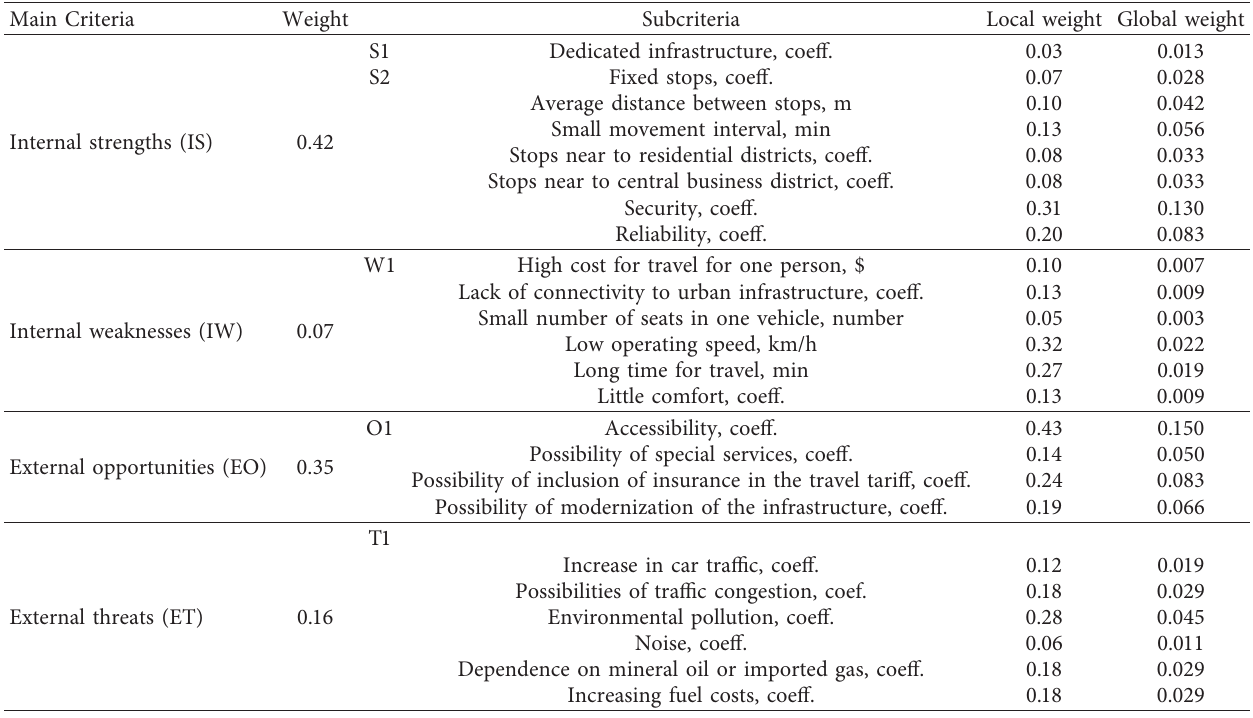
Table 9: Weights of main criteria and